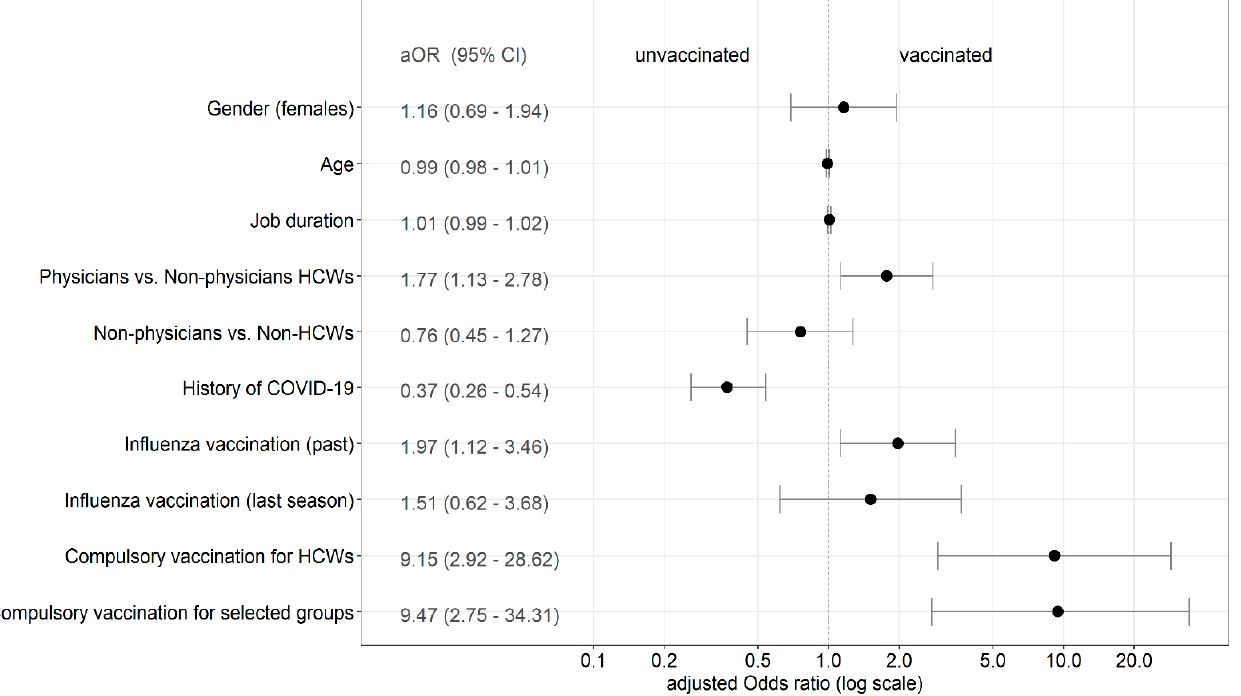
Figure 2. Predictors of COVID-19 vaccination (multivariate logistic regression analysis). Note: HCWs, healthcare workers; OR, Odds ratio; CI, confidence interval.